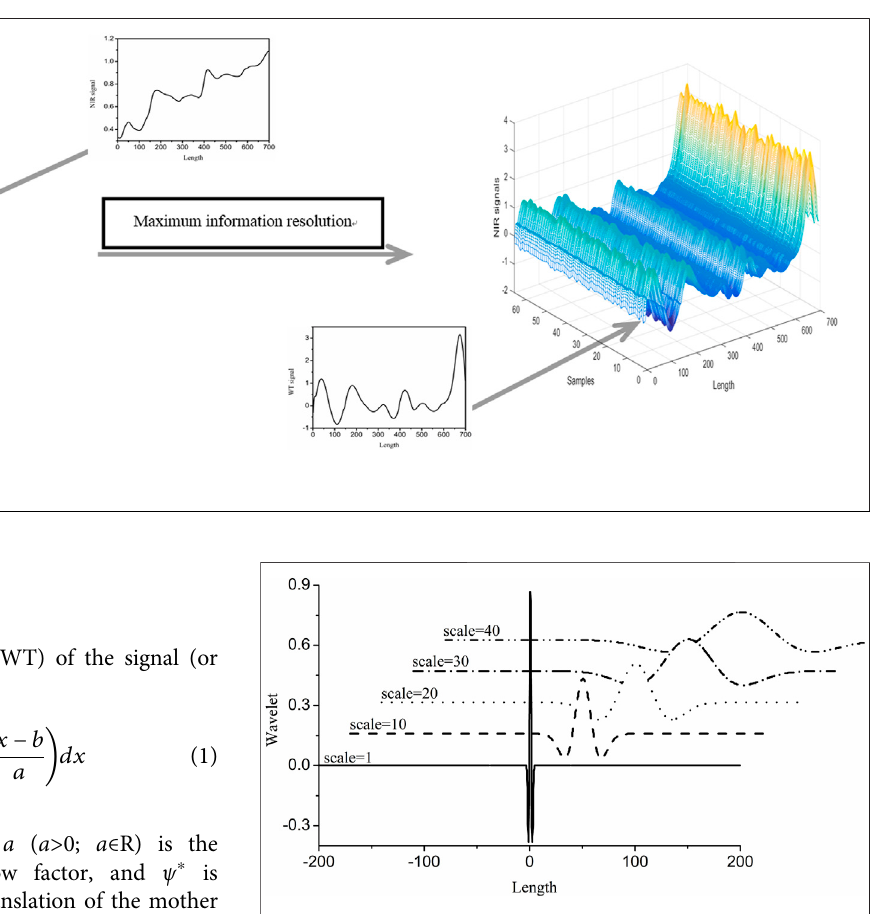
FIGURE 1 | The mexh wavelet with the increasement of a from 1 to